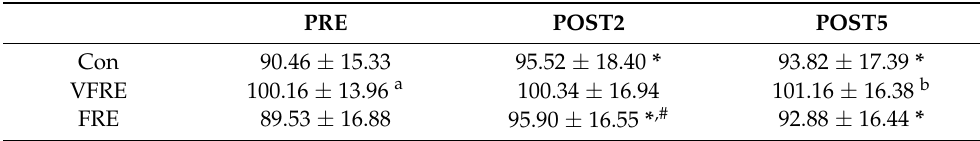
Table 2. The RSI of DJ (cm · s − 1 ); mean ± SD † .